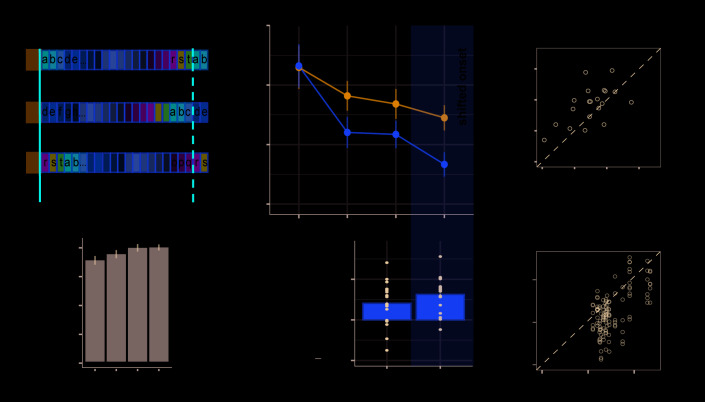
Experiment 4 (N = 20): Implicit memory is robust to pattern phase shifts.(A) In this experiment, six different reoccurring regularities (REGr) per participant were presented. In block 4 (yellow shading in C), these patterns were replaced by versions with shifted onset relative to the originally learned REGr. Two examples of phase shifted REGr and their original REGr version are depicted. The solid red line indicates the transition between RAN and REG (the onset of the regular pattern); the dashed red line denotes one cycle (20 tones) (B) d’ across all blocks. Error bars indicate 1 s.e.m. (C) RT to the transition from RAN to REG pattern across blocks for RANREG and RANREGr.﻿ The bottom plot represents the RT advantage observed in blocks 3 and 4. Error bars indicate 1 s.e.m. Figure 7—figure supplement 1 plots the RT advantage for each intra-block presentation. (D) The individual RT advantage in block three compared with block 4. Each circle represents an individual participant. (E) Plotted is the relationship between RTs to RANREG and RANREGr in block 4. Each circle represents a unique REGr pattern (six per participant), plotted against the mean RT to RANREG for that participant.